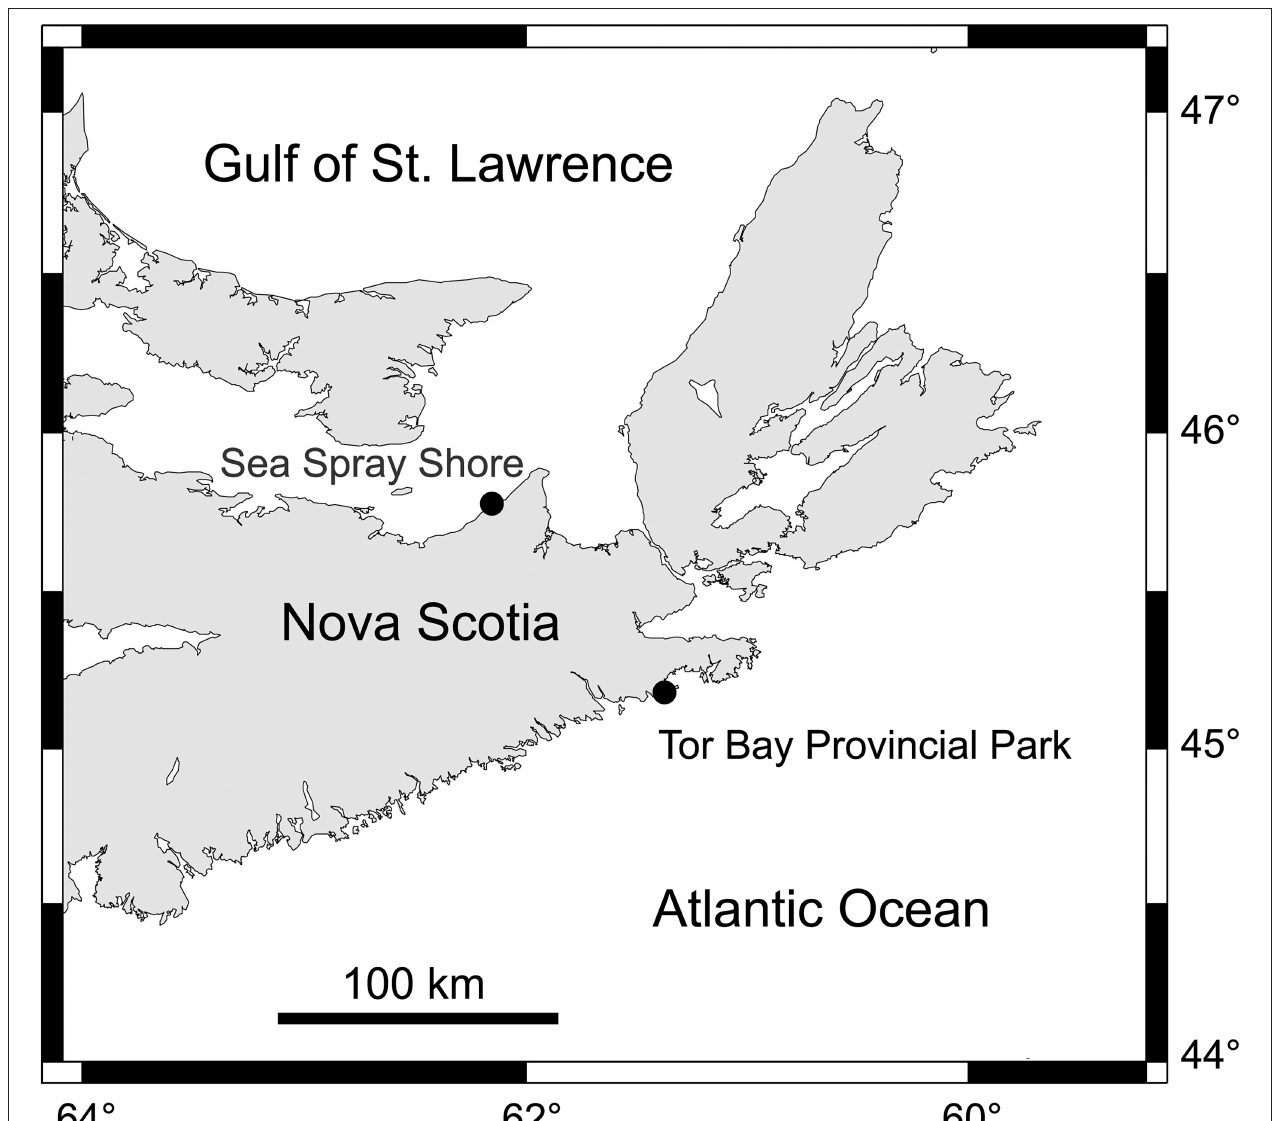
FIGURE 1 | Map showing the position of the two intertidal locations in Nova Scotia (Canada) mentioned in this article: Sea Spray Shore, on the Gulf of St. Lawrence coast, and Tor Bay Provincial Park, on the open Atlantic